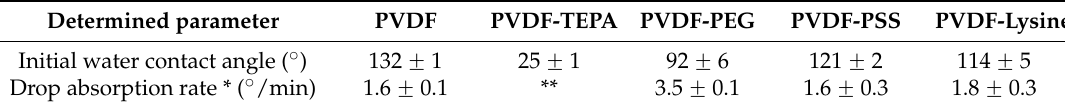
Table 2. Wettability characteristics of modified PVDF